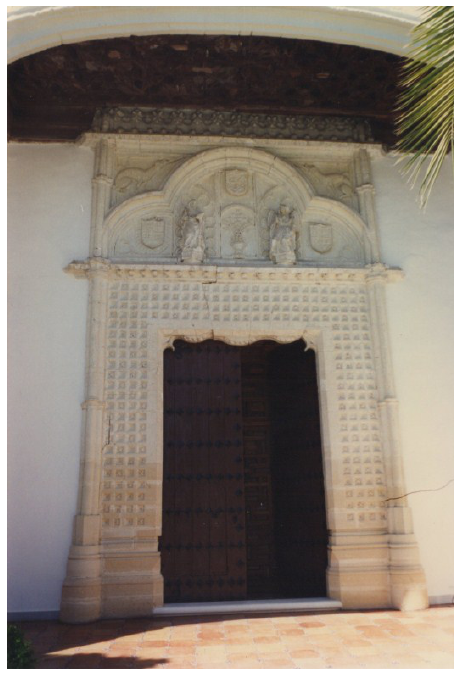
Figure 14. Portal. Madre de Dios Convent. Baena (Cordoba ). Photo took by author.